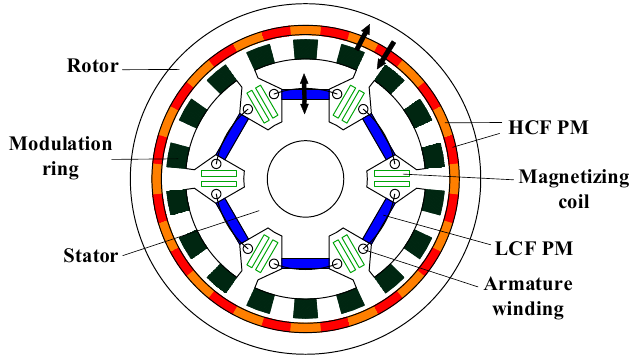
Figure 38. Hybrid PM VFM machine based on magnetic ‐ gearing topology [101].